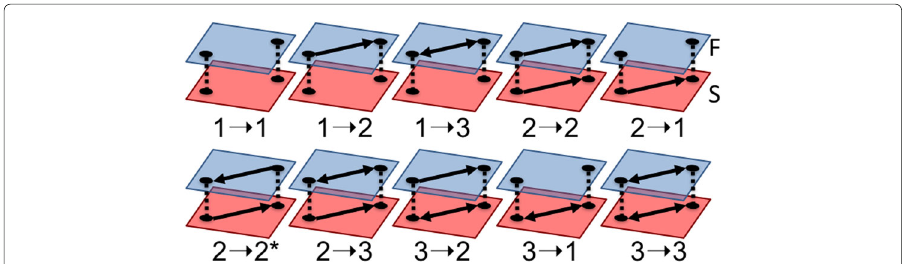
Fig. 3 Dyadic Transformations. All ten nonisomorphic dyadic transformation multiplex subgraphs. We see preservations subgraphs being represented by 1 → 1, 2 → 2 and 3 → 3. 2 → 2 ∗ represents direction reversal of the 2 subgraph. All other transformations are conversion